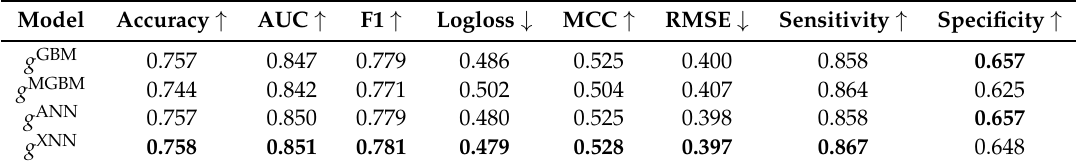
Table 1. Fit measures for g GBM ( X ) , g MGBM ( X ) , g ANN ( X ) , and g XNN ( X ) on the simulated test data. Arrows indicate the direction of improvement for each measure and the best result in each column is displayed in bold